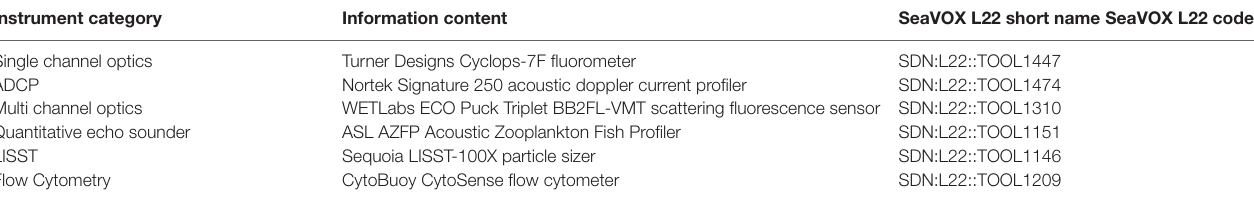
TABLE 2 | Examples of vocabulary standards for OceanSITES instrumentation curated by the SeaVOX Vocab Library Instrument category Information content Single channel